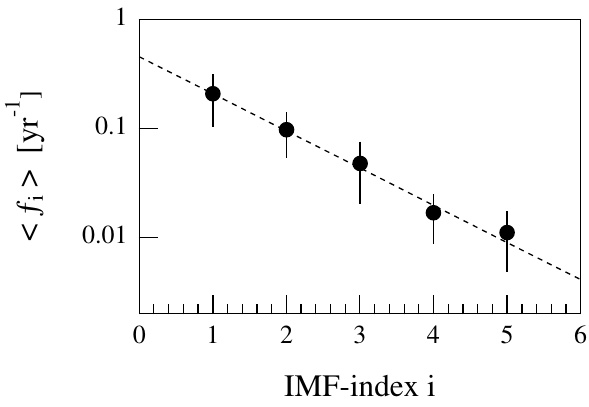
Fig. 4. IMFs c i average frequencies ¯ f j versus IMF index i . The dashed line is a nonlinear best fit using Eq. (8), where f c = [ 0 . 46 ± 0 . 25 ] yr − 1 .